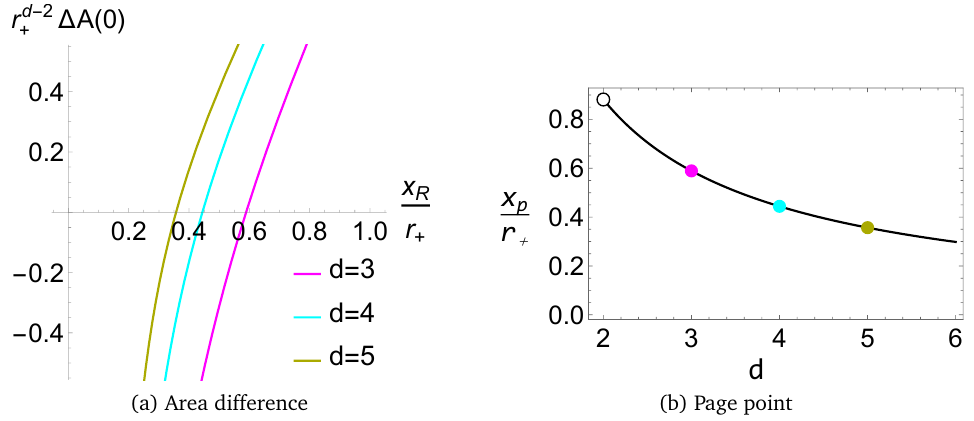
Figure 6: (a) The area difference ∆ A ( 0 ) (53) versus x (49) for d = 3,4,5 and R (b) the Page point x as a function of (analytically-continued) d > 2, all in the AdS- p Schwarzschild geometry and in r + units. The area difference in each dimension monotonically increases with x , crossing 0 at a particular value beyond which we R have Page curves. The Page point thus approaches the brane as we increase d .